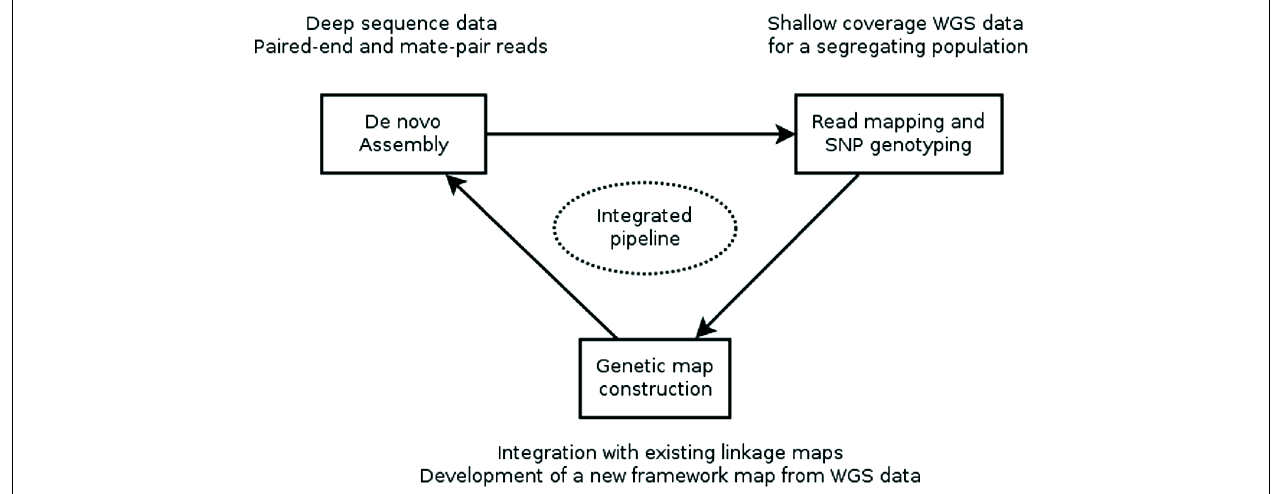
integrated with existing maps. Finally, contigs are placed to the genetic map based on the segregation patterns of the SNP markers they carry. Currently, assembly, SNP genotyping and genetic map construction are performed consecutively with existing general-purpose tools. Future research should focus on developing an integrated pipeline, where an initial assembly is iteratively improved using sequence information from the mapping